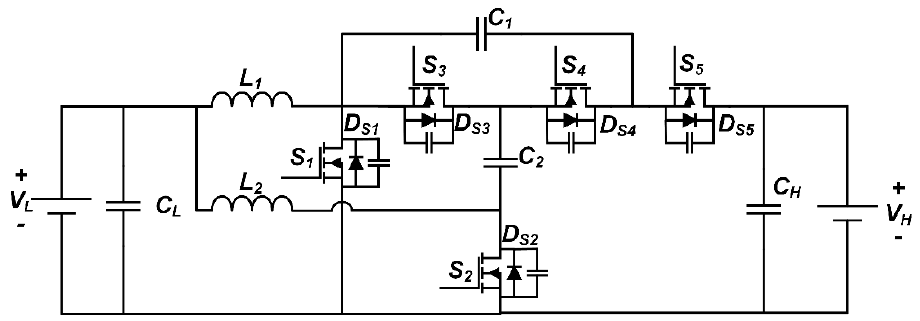
Figure 6. Interleaved bidirectional switched-boost DC–DC converter.